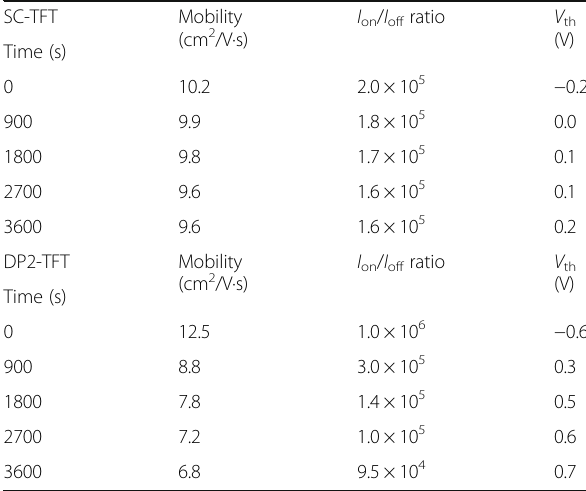
Table 1 The summary of mobility, I on / I off ratio, and V th during PBS test of spin-coated and direct-printed ZrO 2 TFT